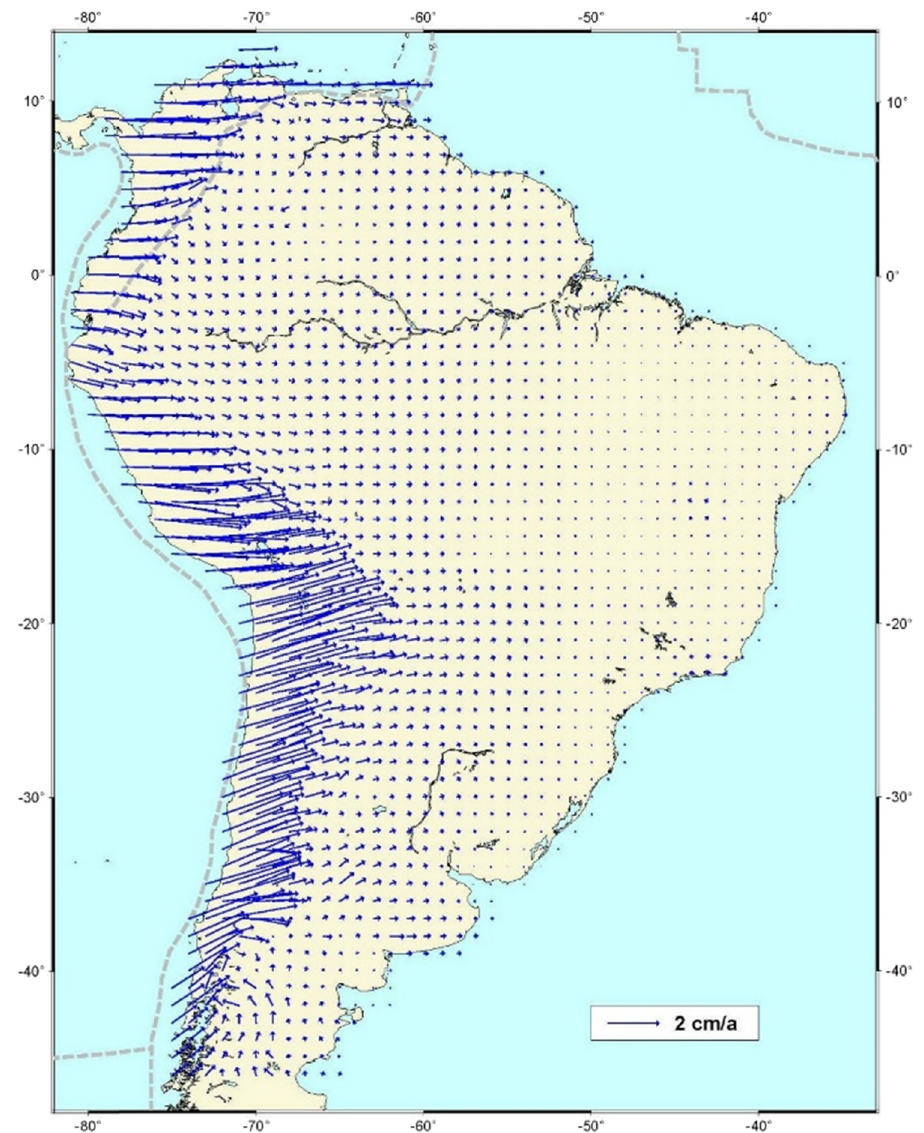
Figure 8: Velocity model for South America ( VEMOS2003 ) relative to the rigid South American